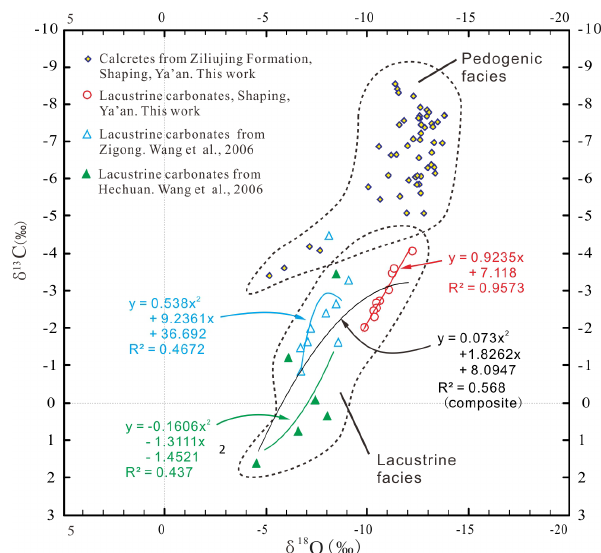
Figure 5. A cross-plot and the covariance of carbon and oxygen iso- topic values of the Lower Jurassic pedogenic and lacustrine carbon- ates from the GSB. Note the pronounced covariance ( R 2 = 0.957) between δ 13 C and δ 18 O from the Shaping section, Ya’an, indicat- ing a compositional arid evaporate and closed pattern lake, and also note the moderate covariance ( R 2 = 0.47 and 0.44) between δ 13 C and δ 18 O from Zigong and Hechuan, indicating a (semi)arid and semi-closed pattern